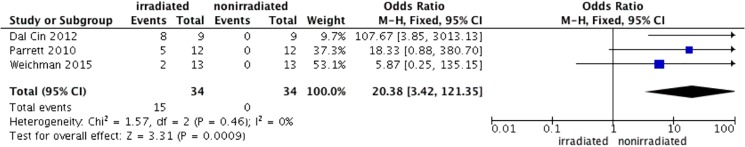
Correlations between radiation and infection.